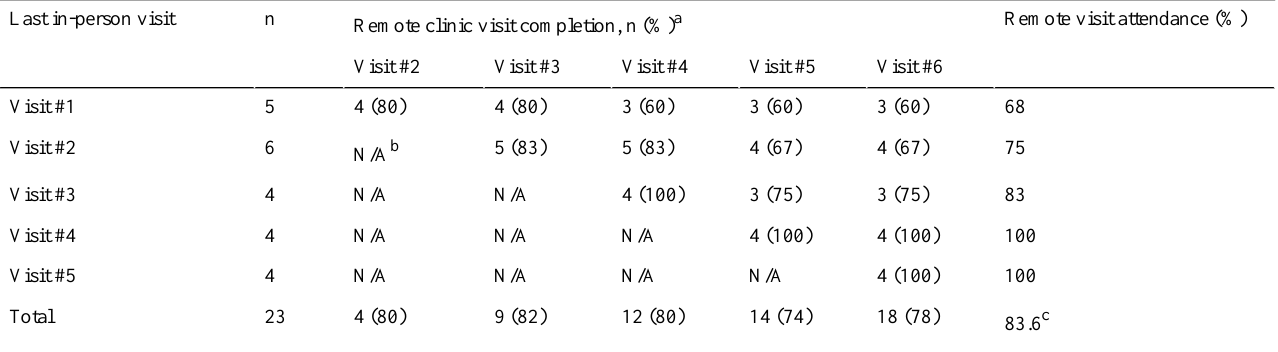
Table 2. Clinic visit attendance among smoking cessation clinical trial participants for the COVID-19 cohort (n=23).